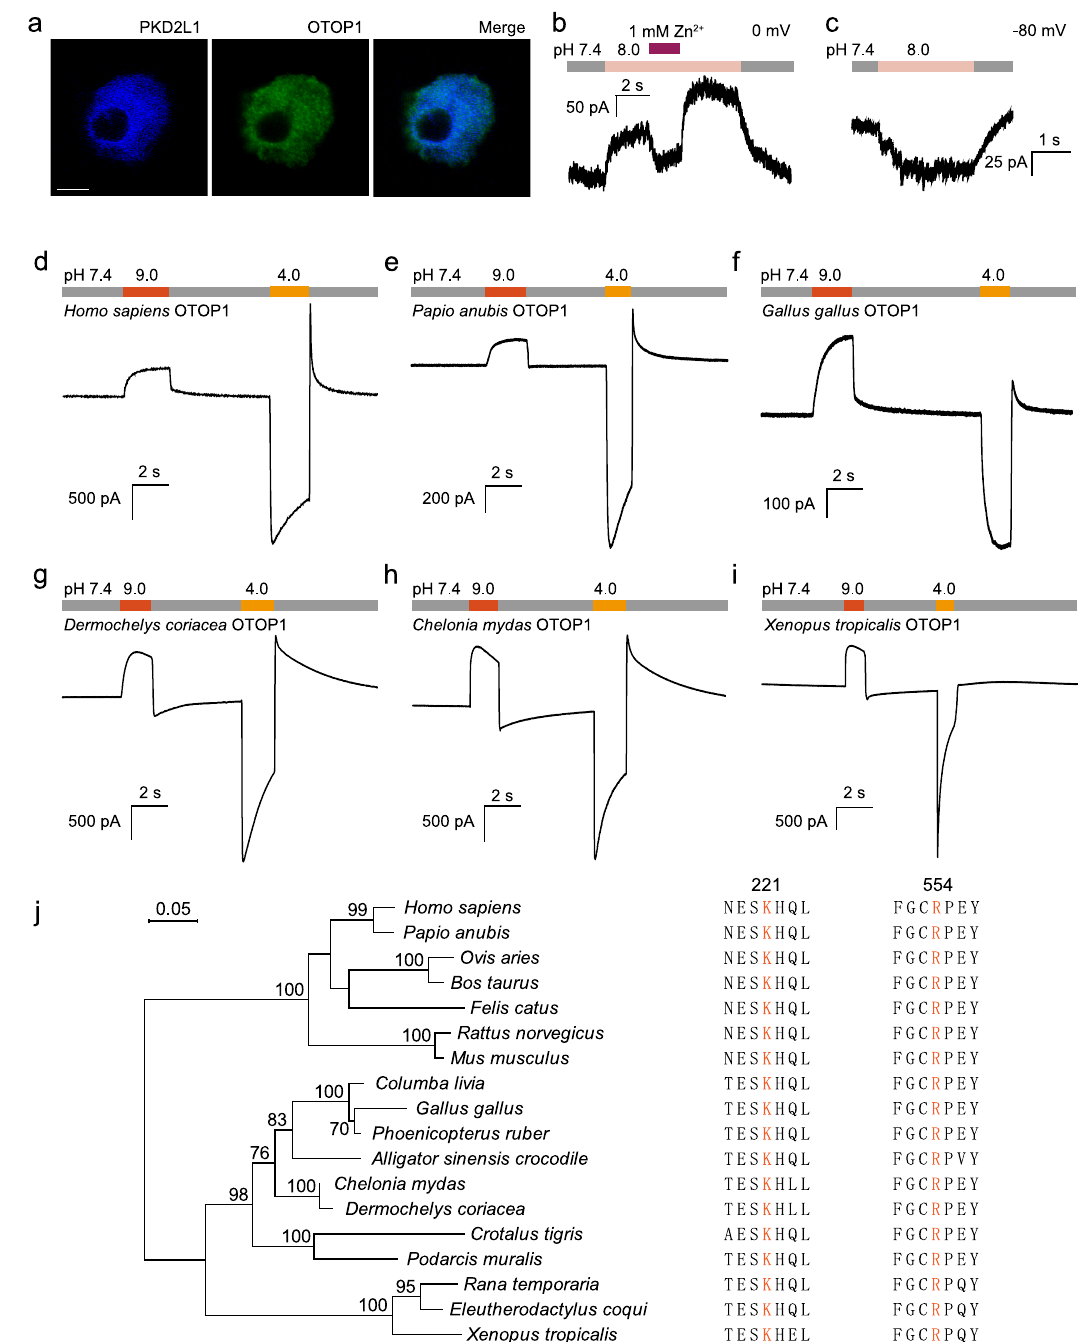
Fig. 4 | Alkaline activation of OTOP1 channels was relatively conserved in vertebrates. a Confocal image showing taste cells from mice with antibodies against OTOP1 (green), and PKD2L1 (blue). Scale bar, 5 μ m. b Currents in response to pH 8.0 NMDG-based extracellular solution in isolated taste cells. 1mM Zn 2+ inhibited outward current generated by pH 8.0 extracellular solution. c Inward current was induced in isolated taste cells by pH 8.0 extracellular solution under physiologicalconditions. d – i Representativewhole-cellrecordingsofsixvertebrate OTOP1channelsinresponsetoNa + -freeextracellularsolutionswithdifferentpH(as